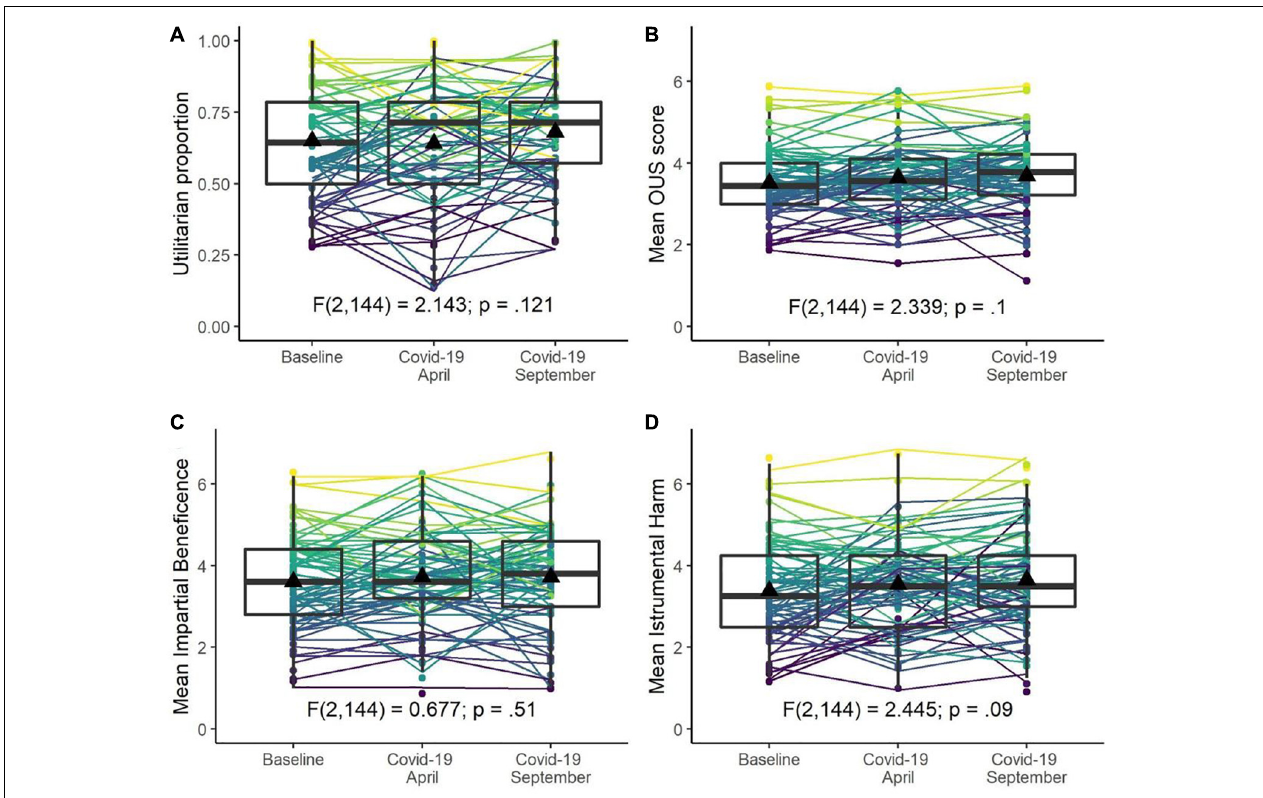
FIGURE 4 | Moral decision-making before and during the COVID-19 pandemic. Proportion utilitarian responses to moral dilemmas (A) , mean Oxford Utilitarianism Scale (OUS) score (B) , mean Impartial Beneficence subscale score (C) , and mean Instrumental Harm subscale score (D) at baseline (timepoint 1) and during the COVID-19 pandemic (timepoints 2 (Covid-19 April) and 3 (Covid-19 September). Boxplots show medians and interquartile ranges; triangles represent mean scores for each timepoint. Colours represent baseline scores for each participant.